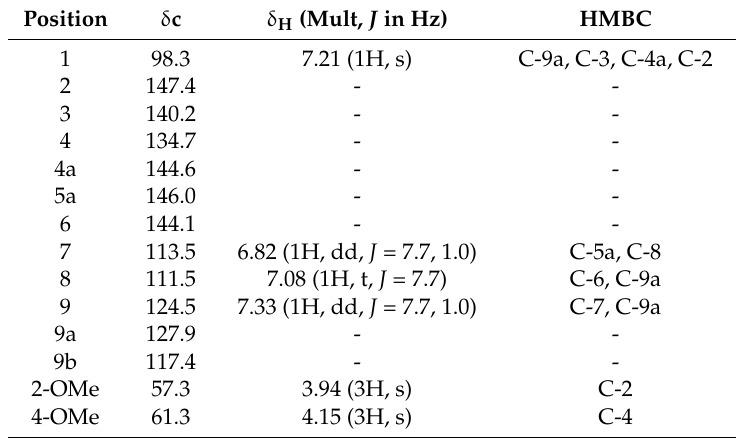
Table 1. NMR spectral data of 3,6-dihydroxy-2,4-dimethoxy-dibenzofuran ( 9 ) ( δ values, in CD 3 OD, J in